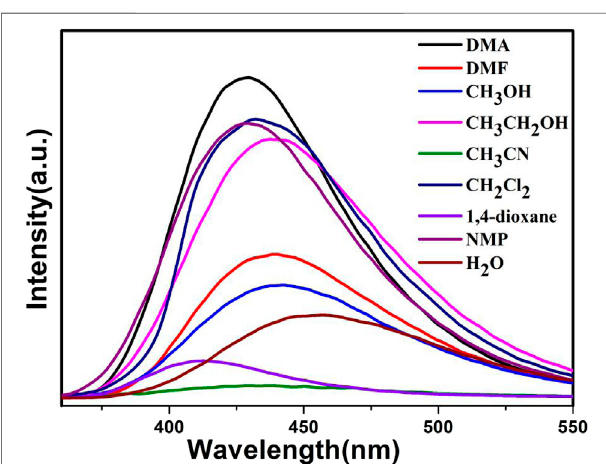
FIGURE 7 | Fluorescent analysis of 1a toward various metal ions (10 – 2 M) in DMA solution.